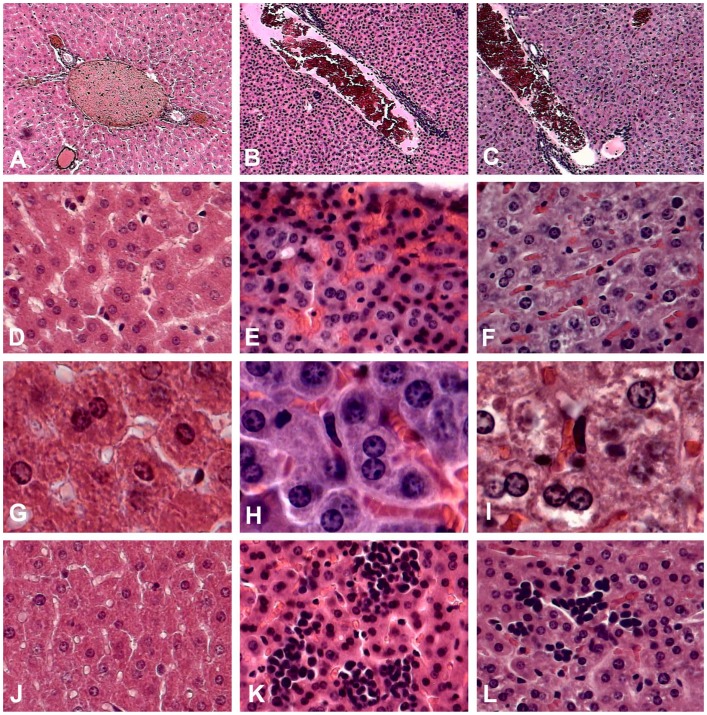
Histopathological analysis of liver sections from AG129 mice under different experimental conditions.A, D, G, J. Untreated and uninfected control mice. B, E, H, K. Untreated infected mice. C, F, I, L. LOV-treated infected mice. A–C. Comparison between venular portal sections. In infected mice (B) there was congestion with chronic inflammatory lymphocytes compared with normal mice (A), and in mice treated with LOV, the infiltration was lower (C). D–F. Sinusoids comparison. Sinusoidal congestion was observed in untreated infected mice (E), and this was reduced in LOV-treated mice (F). In normal mice, there was no congestion (D). G–I. In LOV-treated (I) or untreated (J) mice there was hyperplasia of Kupffer cells compared with normal mice (G). J–L. In infected mice, massive extramedullar erythropoiesis was observed (K). In LOV-treated mice, erythropoiesis was minor and the number of outbreaks was lower (L). In untreated and uninfected control mice, erythropoiesis was not observed (J).